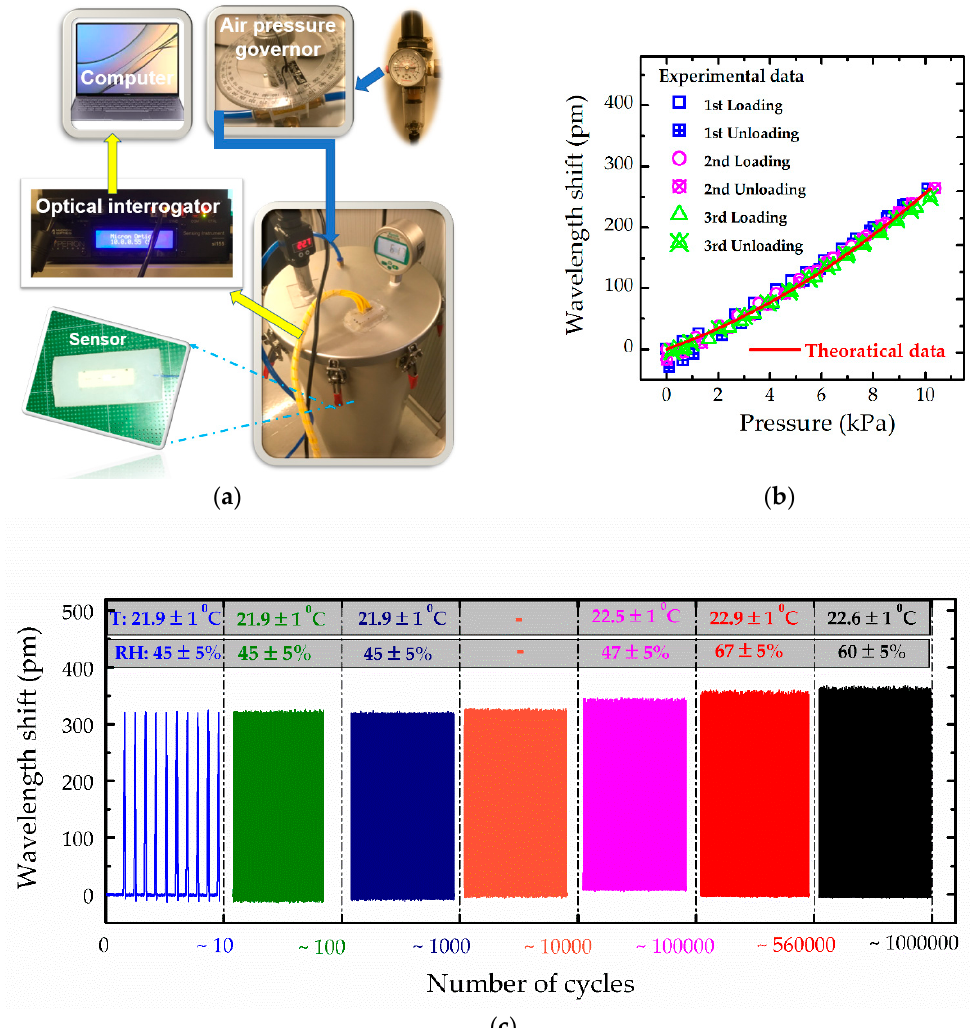
Figure 3. ( a ) Schematic of the calibration system; ( b ) Comparison between experimental results and theoretical results, where the thickness of the film is about 1.01 mm, and elastic modulus of the film is 1.3 MPa according to the experimental results shown in Figure S1, temperature is 22.6 ± 0.2 °C, and other parameters are consistent with those listed in Table 1; and ( c ) Results of cyclic compression, where the experiment was carried out on a keyboard life tester, setup in a room environment, the peak pressure is about 20 kPa and the frequency is 2.2 Hz.